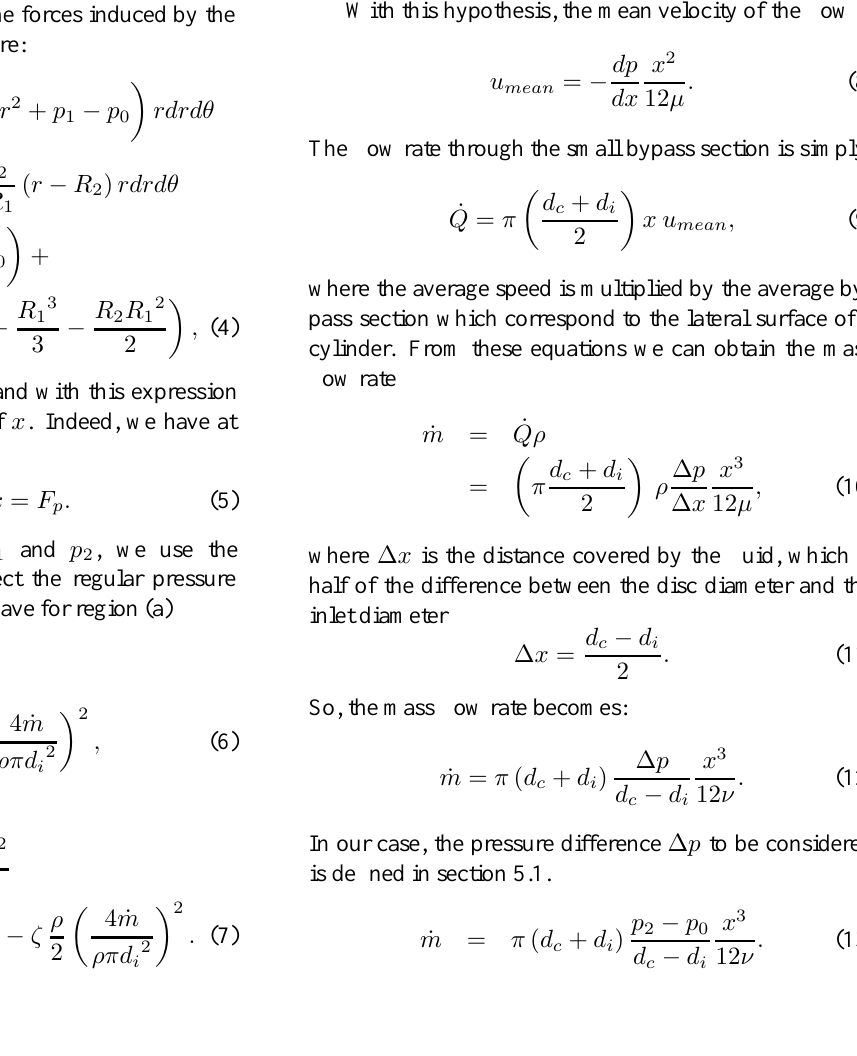
Fig. 4: Flow between the disc and the seat (a) real case; (b)